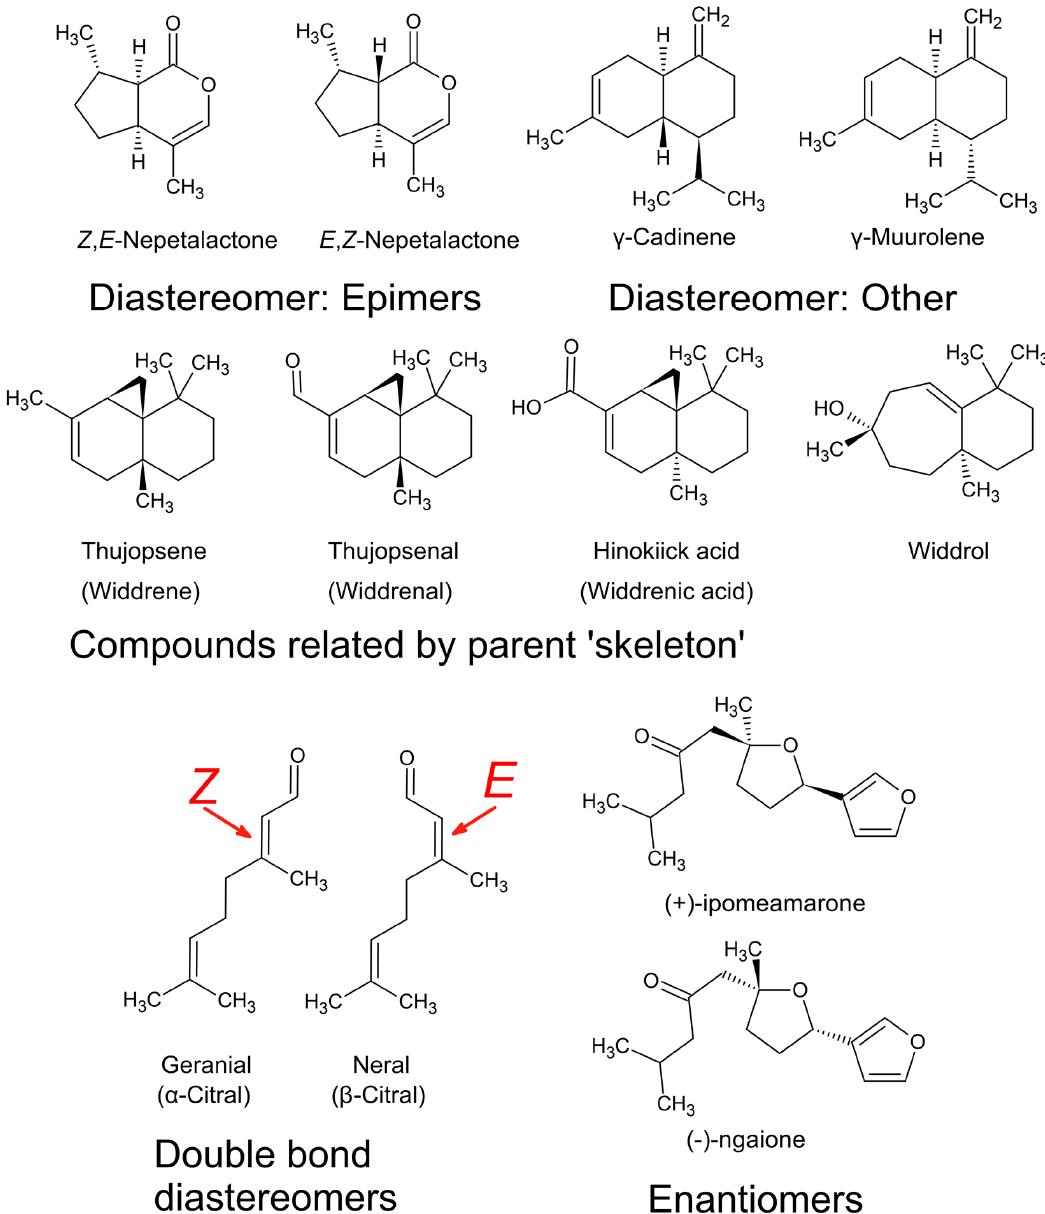
Figure 11. Examples of some diastereomers, enantiomers, and a series related by their parent skeleton, with their vernacular names.